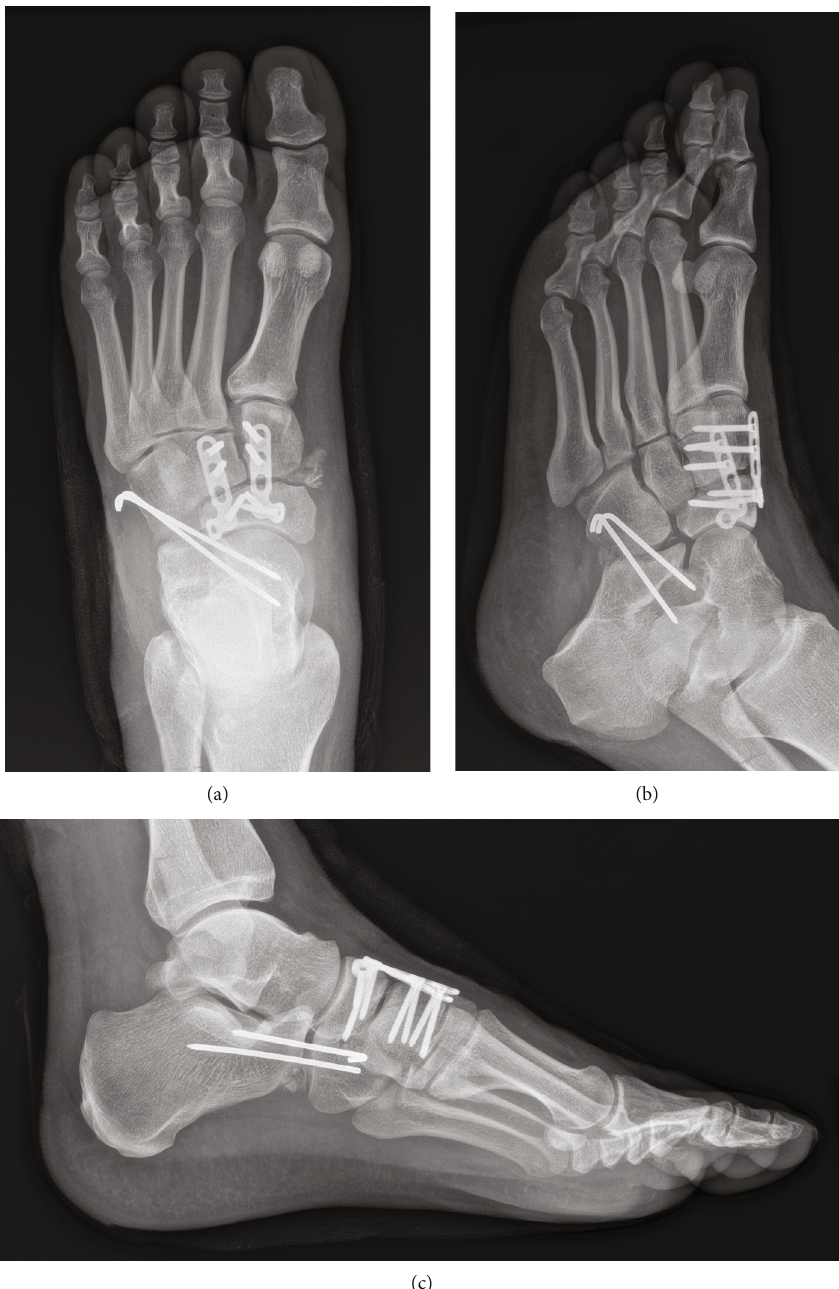
Figure 5: (a) Anteroposterior, (b) oblique, and (c) lateral X-rays of the left foot after open reduction, showing internal fi xation of N-C1 and N-C2 joints, and pinning of the calcaneocuboid